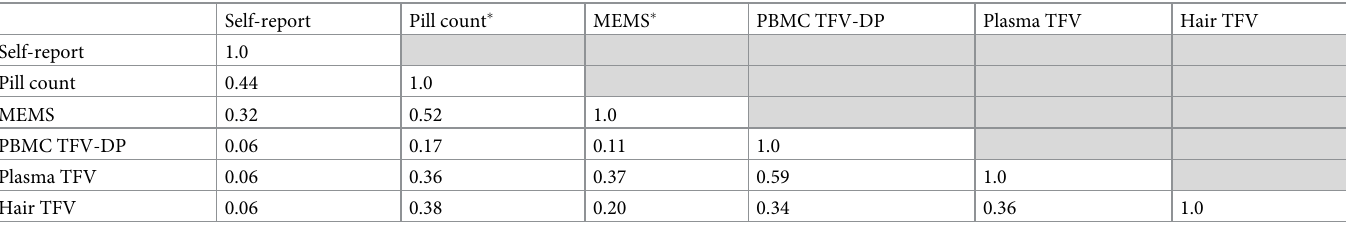
Table 3. Spearman correlation coefficients between various measures of TDF exposure in active arm participants only (n = 47) in the US CDC PrEP safety study. Self-report